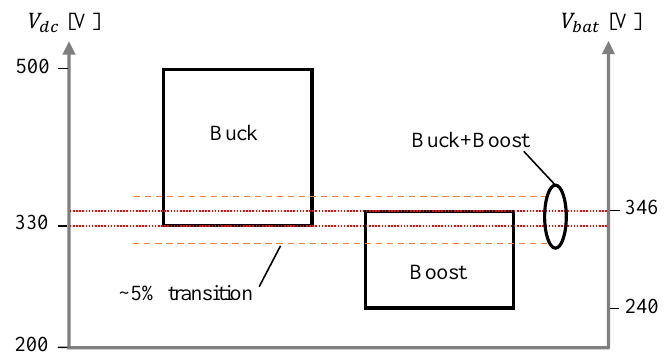
Figure 6. Mode selection for the bidirectional cascaded buck and boost converter.